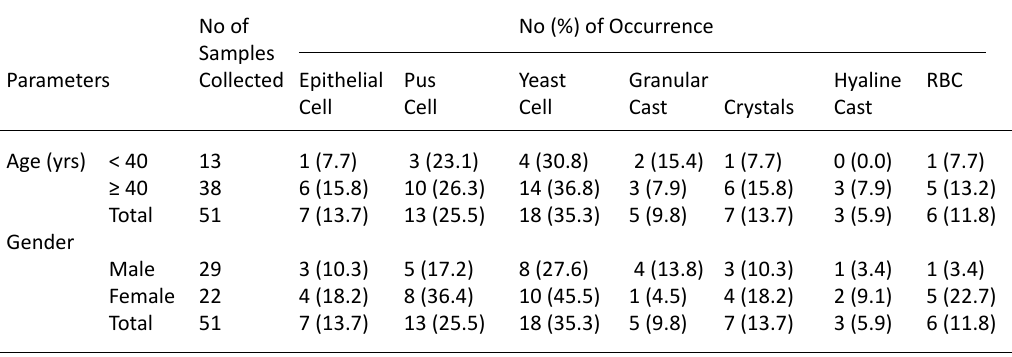
RBC: Red Blood Cell. values in parentheses expressed the